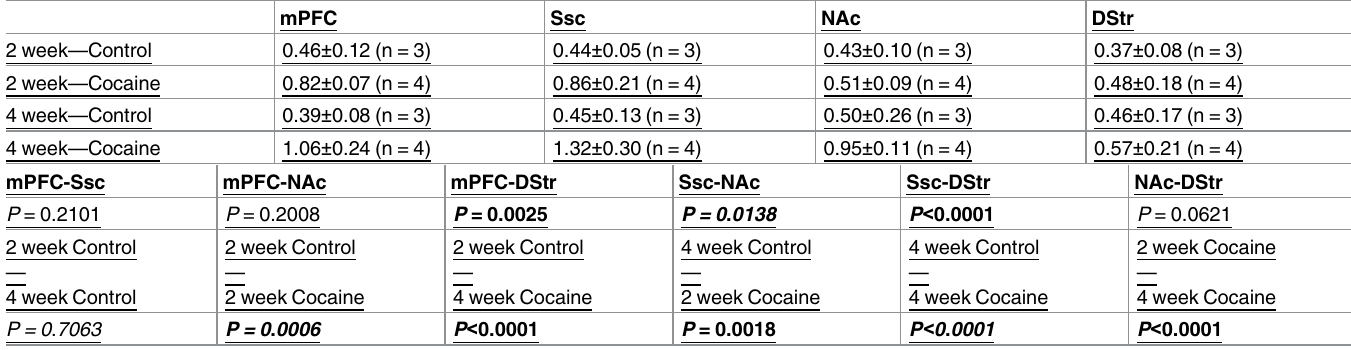
Table 3. VEGF expression (mean ± Std) in different brain regions including mPFC, Ssc, NAc and DStr, following cocaine treatment for 2 weeks and 4 weeks. P values calculatedusing two-way ANOVA (SAS) are listed below. Significant P values ( P < 0.05)are bolded.